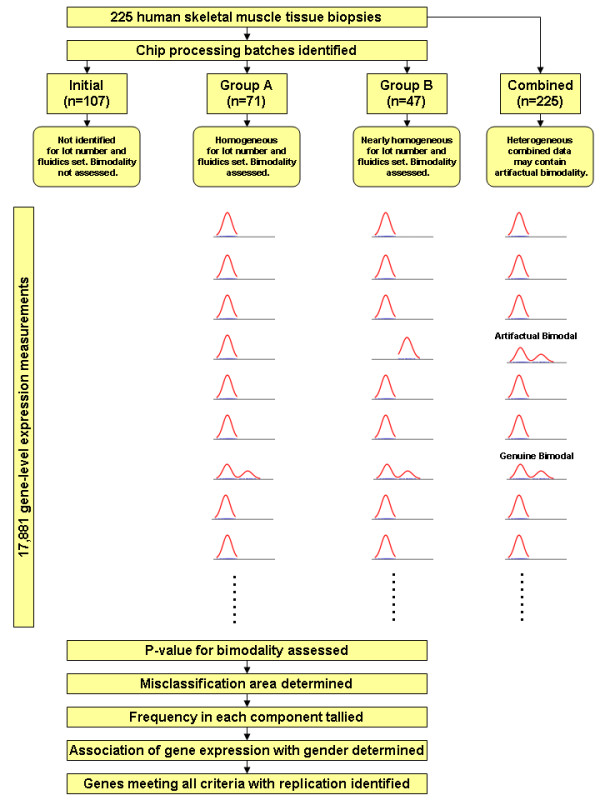
Identification of genes with bimodal expression. Muscle samples from 225 individuals were processed in groups that could be identified for distinct batch effects influencing the expression levels. Bimodality was assessed in groups of microarrays that were homogeneous for such bias. A variety of constraints were applied to ensure bimodal genes identified were genuine, including replication. Also illustrated is how bimodality may be artifactually (incorrectly) inferred due to heterogeneity of batch effects on expression levels.